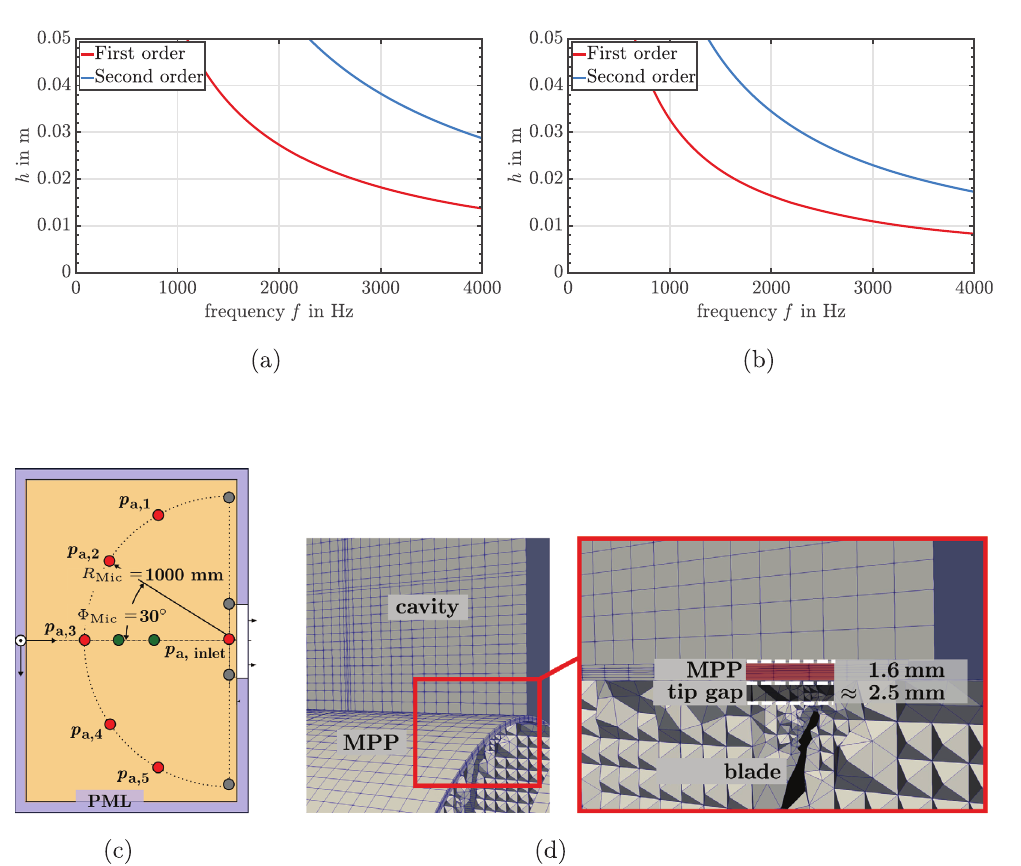
Figure 6. Discretization, monitoring points and enhanced view of MPP-cavity intersection. (a) hq-relation for air domain according to (6). (b) hq-relation for MPP domain at largest simulated frequency 1600 Hz with effective speed of sound of 205 ms (cid:4) 1 . (c) Pressure monitoring points in measurement plane. (d) MPP volume region with cavity enhanced view of